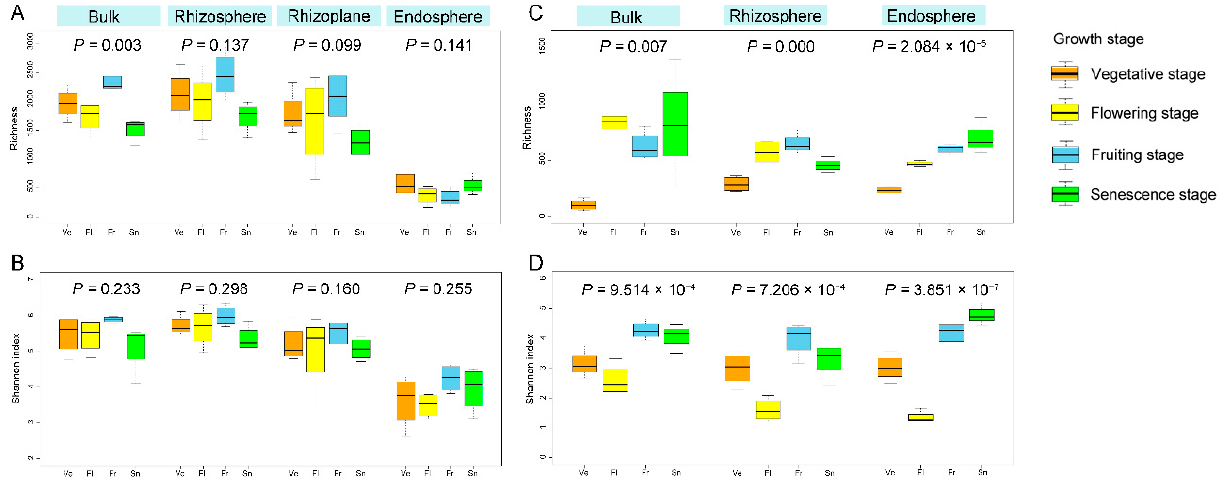
Figure 7. Growth stage changes of the estimated OTUs richness and Shannon diversity for bacterial ( A , B ) and fungal ( C , D ) communities in the bulk soil, rhizosphere, rhizoplane, and endosphere compartments. The p values indicate significance between the four growth stages.